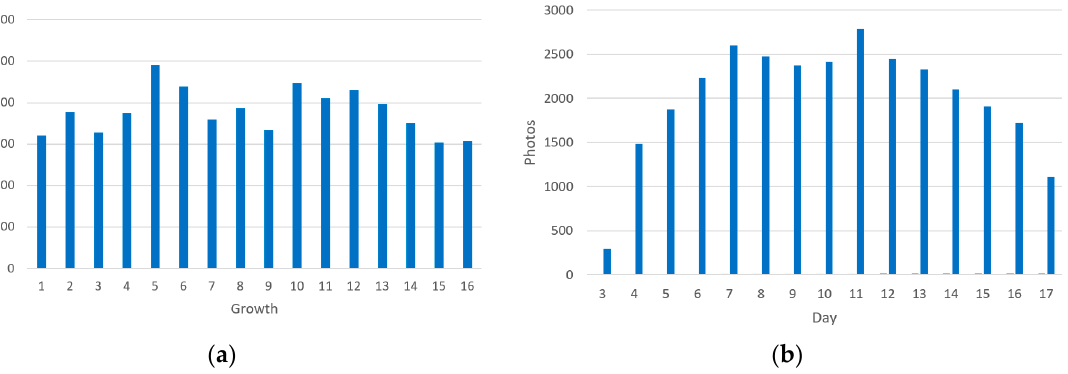
Figure 11. Valid photos collected during 16 cultivations ( a ) number of photos for each growth; ( b ) distribution of photos by growth day.